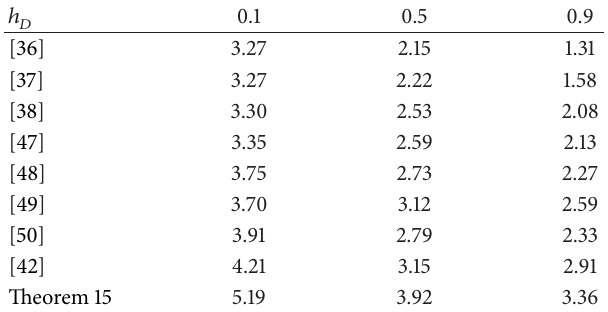
Table 5: Maximum allowable upper bounds ℎ for different ℎ 𝐷 in